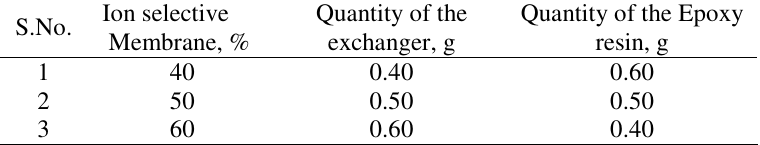
Table 2. Composition of the ingredients for the preparation of membranes